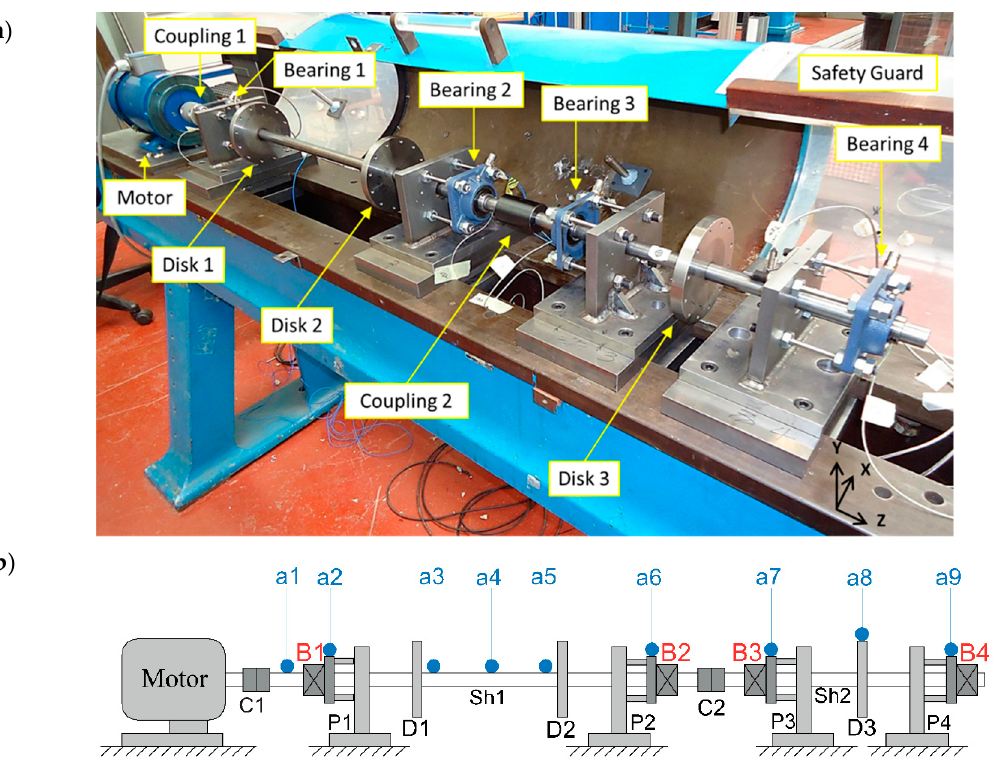
Figure 1. Experimental rig. ( a ) Experimental setup [20]; ( b ) Schematic of the experimental rig. The rig consists of two shafts, Sh1 and Sh2, with a length of 1.0 m and 0.5 m, respec- tively. Both are coupled by a rigid coupling, C2, and rest on 4 ball bearings, B1 to B4, mounted on four flexible pedestals, P1 to P4. Balancing discs D1 and D2 are mounted on Sh1, while D3 is on Sh2. The rig is driven by an electric motor, connected to Sh1 by a flexible coupling, C1, which is used in order to avoid the transmission of vibration from the motor to the rotor. The steel base acts as foundation of the machine. Locations a1 to a9 in Figures 1 and 2 represent the measurement locations used in the modal test, where natural frequencies and mode shape were obtained [20]. The natural frequencies of the rig are 50.66 Hz, 56.76 Hz, 59.2 Hz, and 127 Hz. Figure 2 has the first 2 mode shapes of the experimental rig